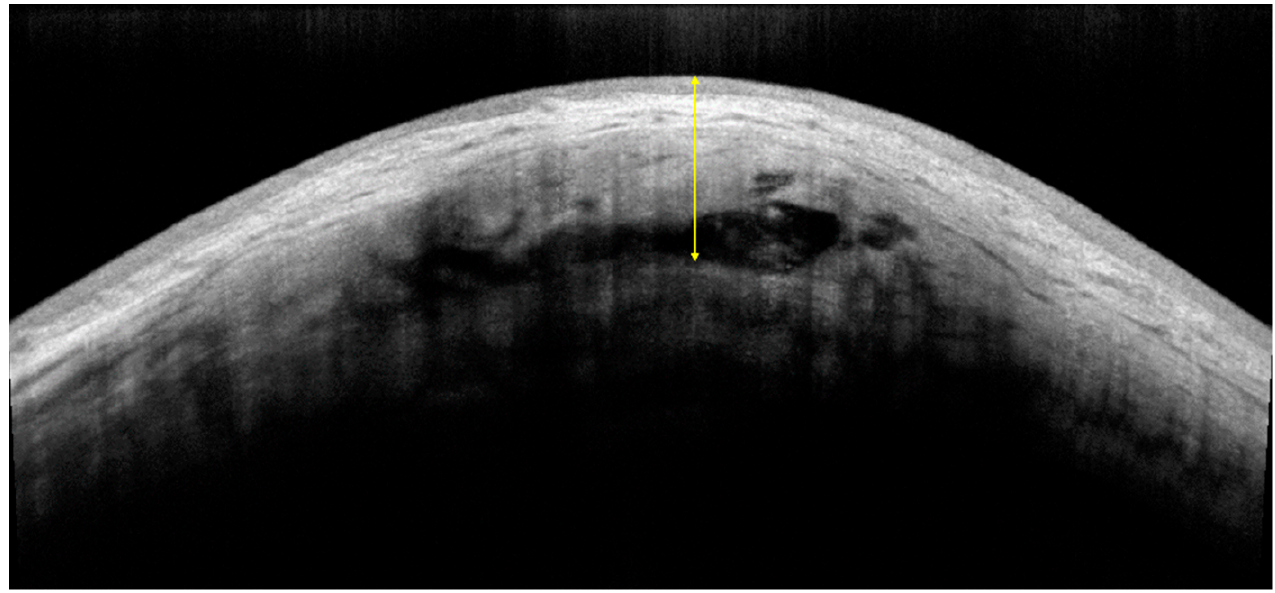
Figure 3. Bleb height evaluation method. Anterior segment optical coherence tomography (AS-OCT) image showing the measuring method of bleb height (yellow arrow lines).